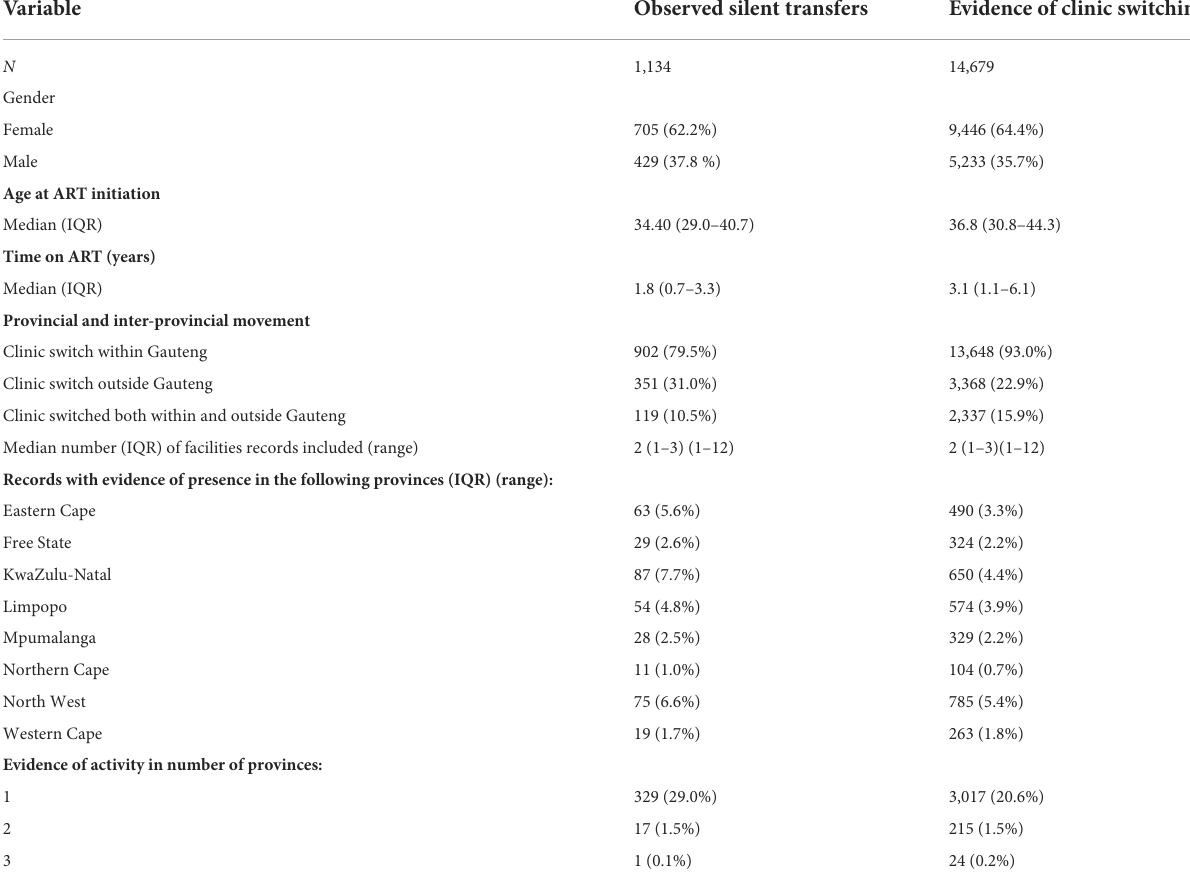
TABLE 6 Clinic switching and silent transfers among patients with HIV accessing care at Themba Lethu Clinic (TLC). Variable Observed silent